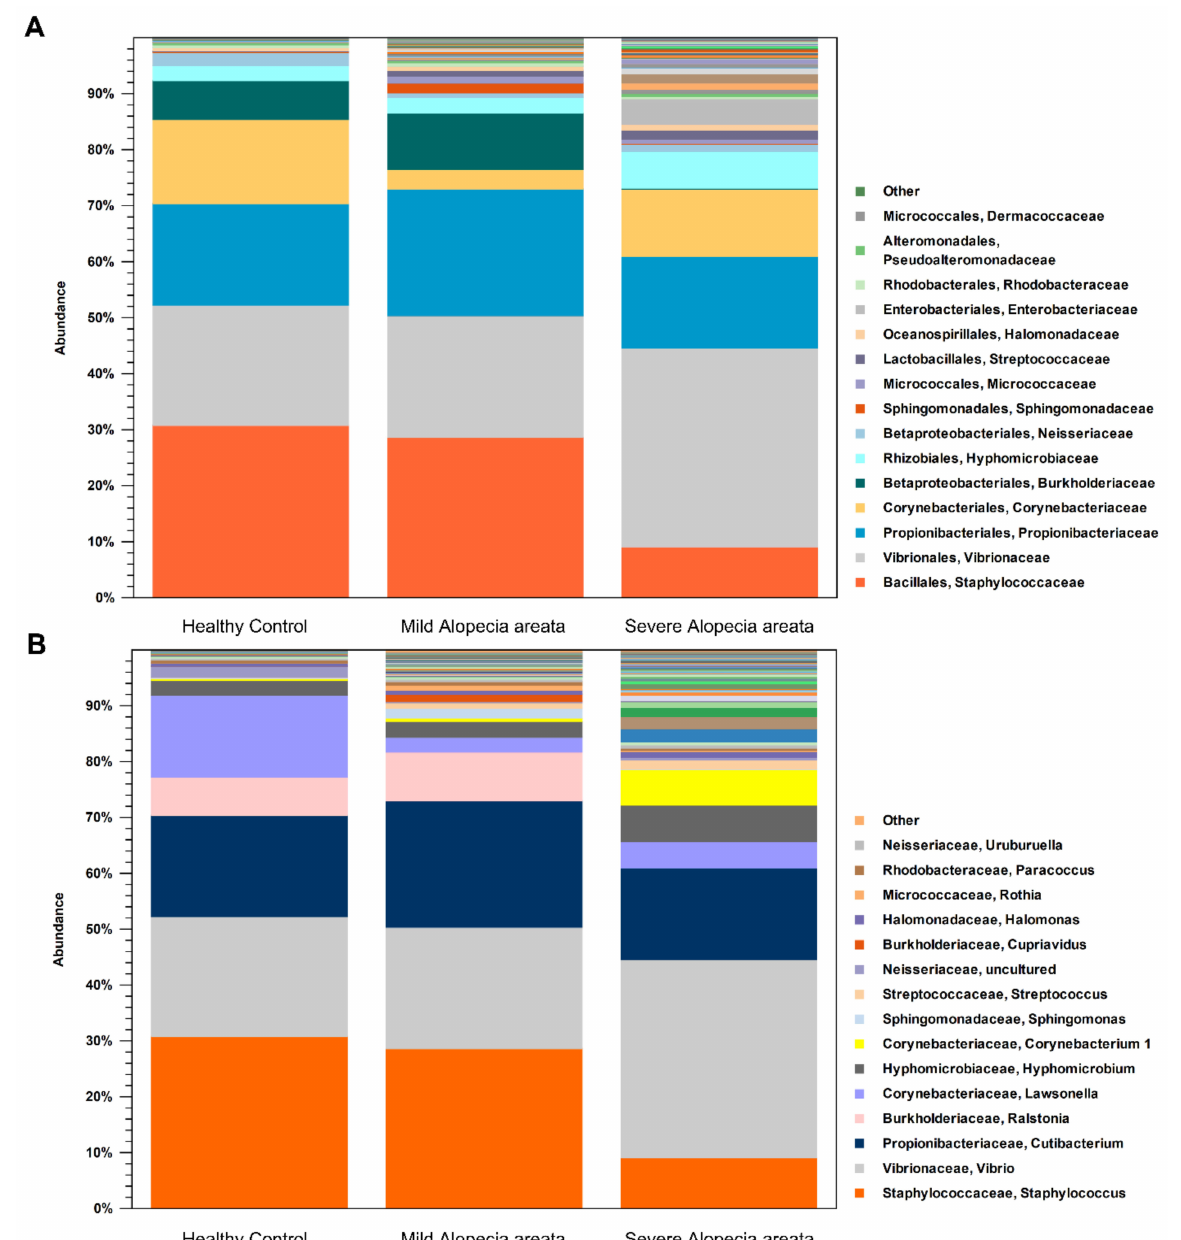
Figure 2. Composition of the scalp microbiome in AA patients ( A ) at the Family level, Staphylo- coccoceae was significantly reduced among scalp microbiome in severe AA. ( B ) At the Genus level, Staphylococcus species was significantly reduced but Corynebacterium species was markedly increased in severe